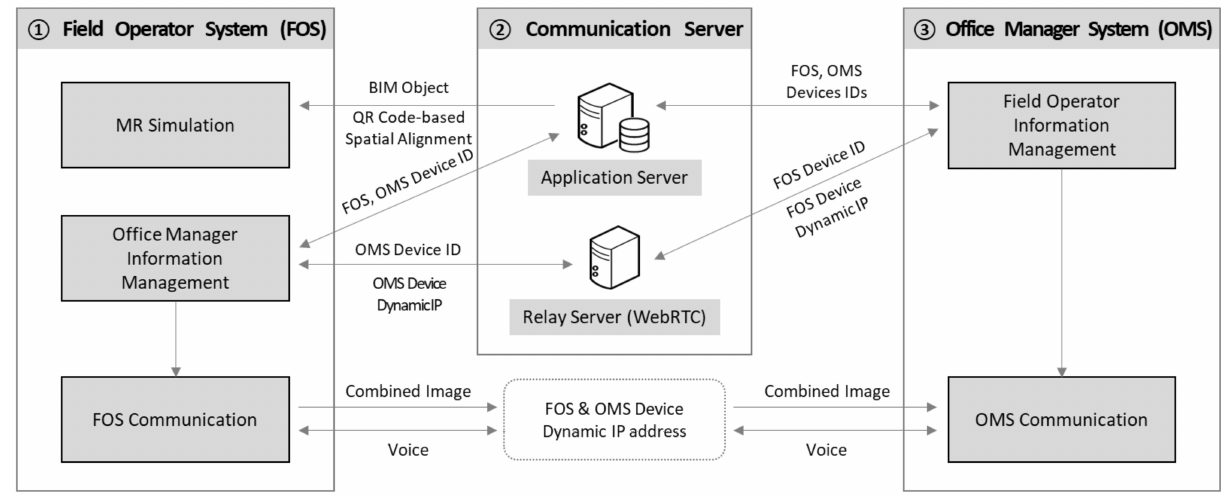
Figure 1. Overall System Architecture.